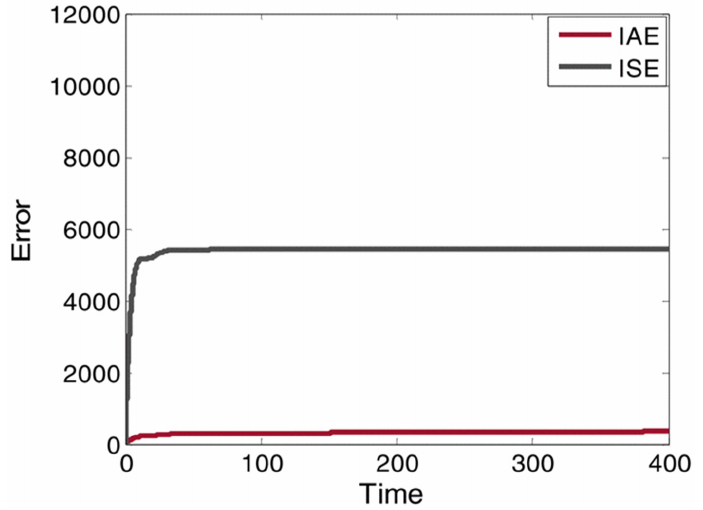
Figure 17. Ambulance output response comparison of fractional-order PID, along with PSO.